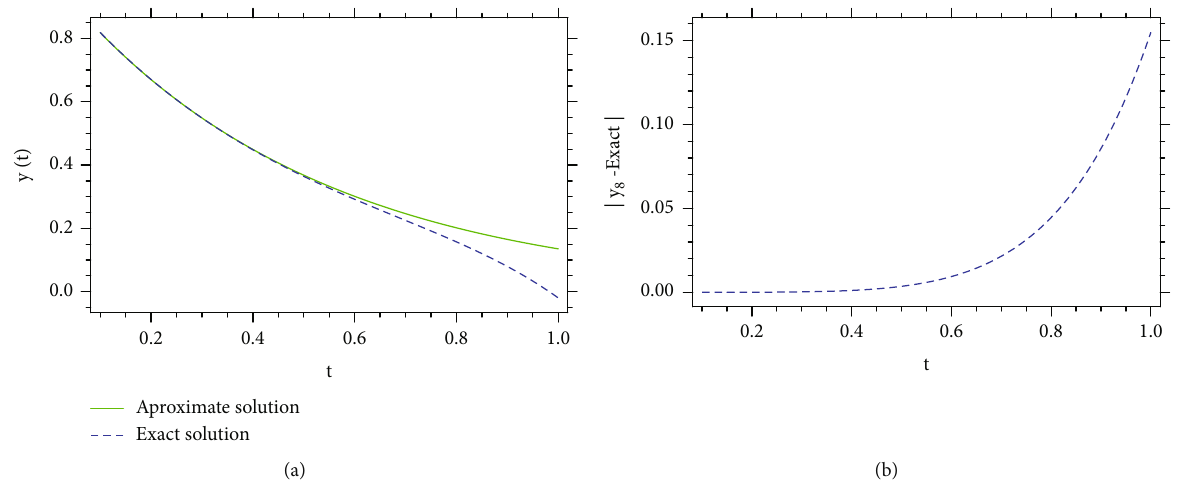
Figure 2: (a) 2D solution plots of Example 2 obtained by the present method in comparison with the exact solutions. (b) The absolute errors of Example 2.